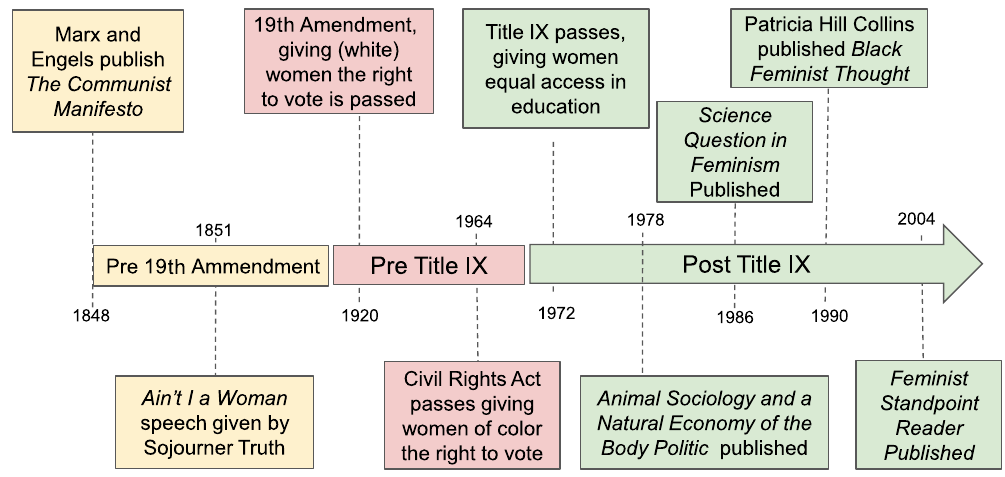
FIG. 2. Timeline of historical events leading to feminist standpoint